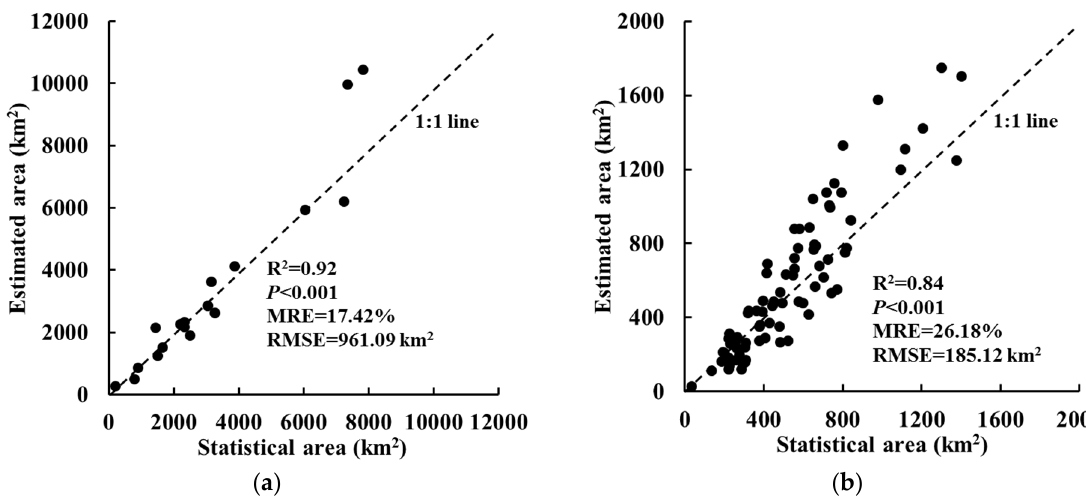
Figure 7. Comparison of estimated wheat areas and statistical areas at the ( a ) municipal and ( b ) county levels in Henan Province in 2018.